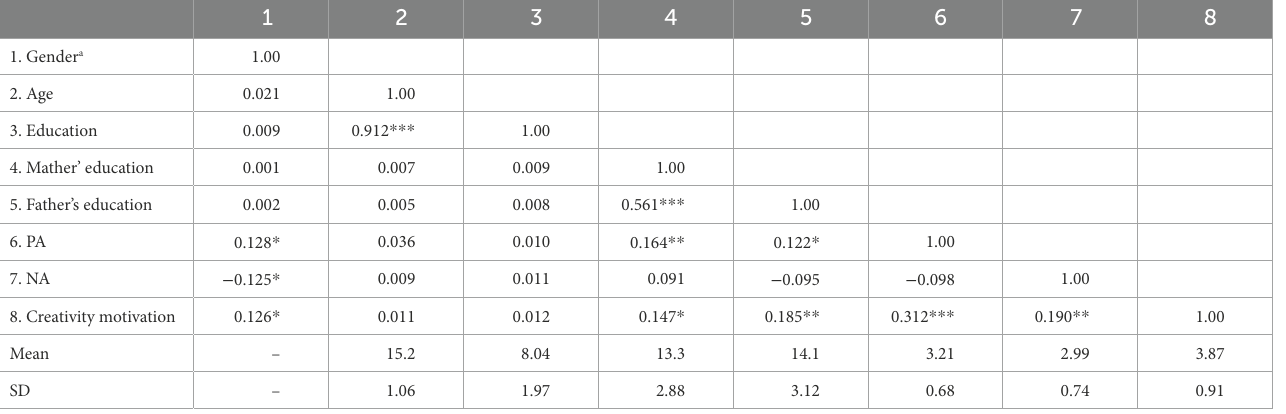
TABLE 1 Means, standard deviations (SDs), and correlations between variables of Study 1 ( n =